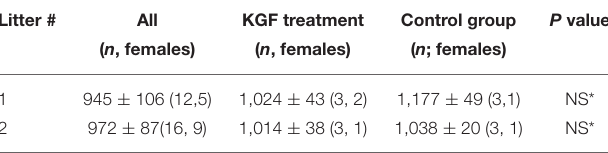
TABLE 1 | Litter and group sizes, body weights, and gender distribution for preterm pigs harvested from two sows at gestational day 102. Litter #